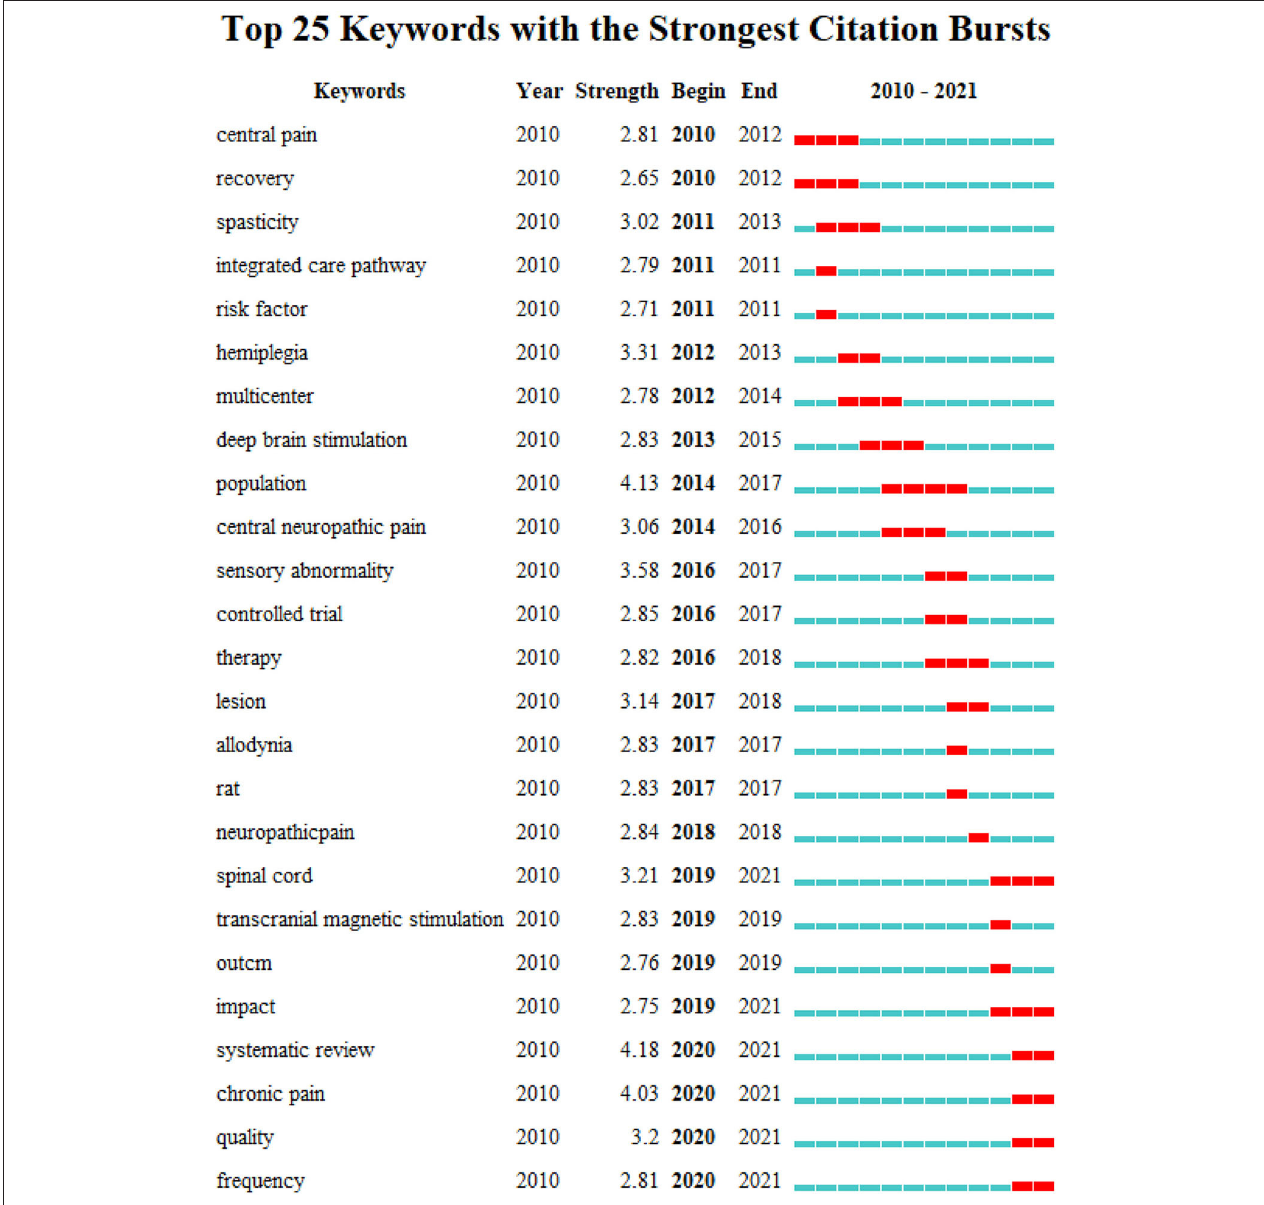
FIGURE 10 | The keywords with the strongest citations bursts of publications on pain after stroke.